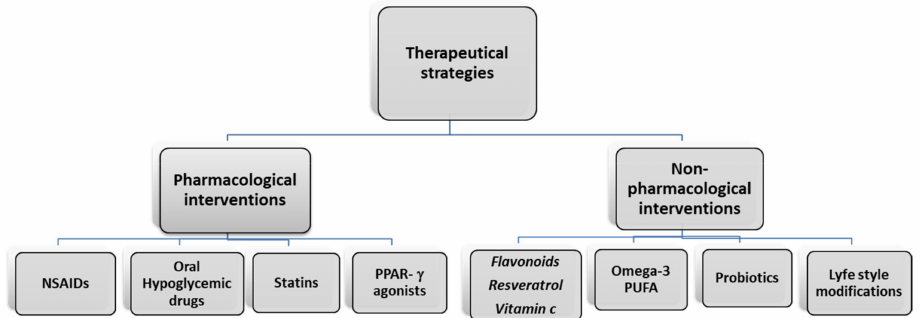
Figure 3. Pharmacological and non-pharmacological interventions to prevent CVD complications in obesity. Peroxisome proliferator-activated receptor gamma (PPAR- γ ); non-steroidal anti-inflammatory drugs